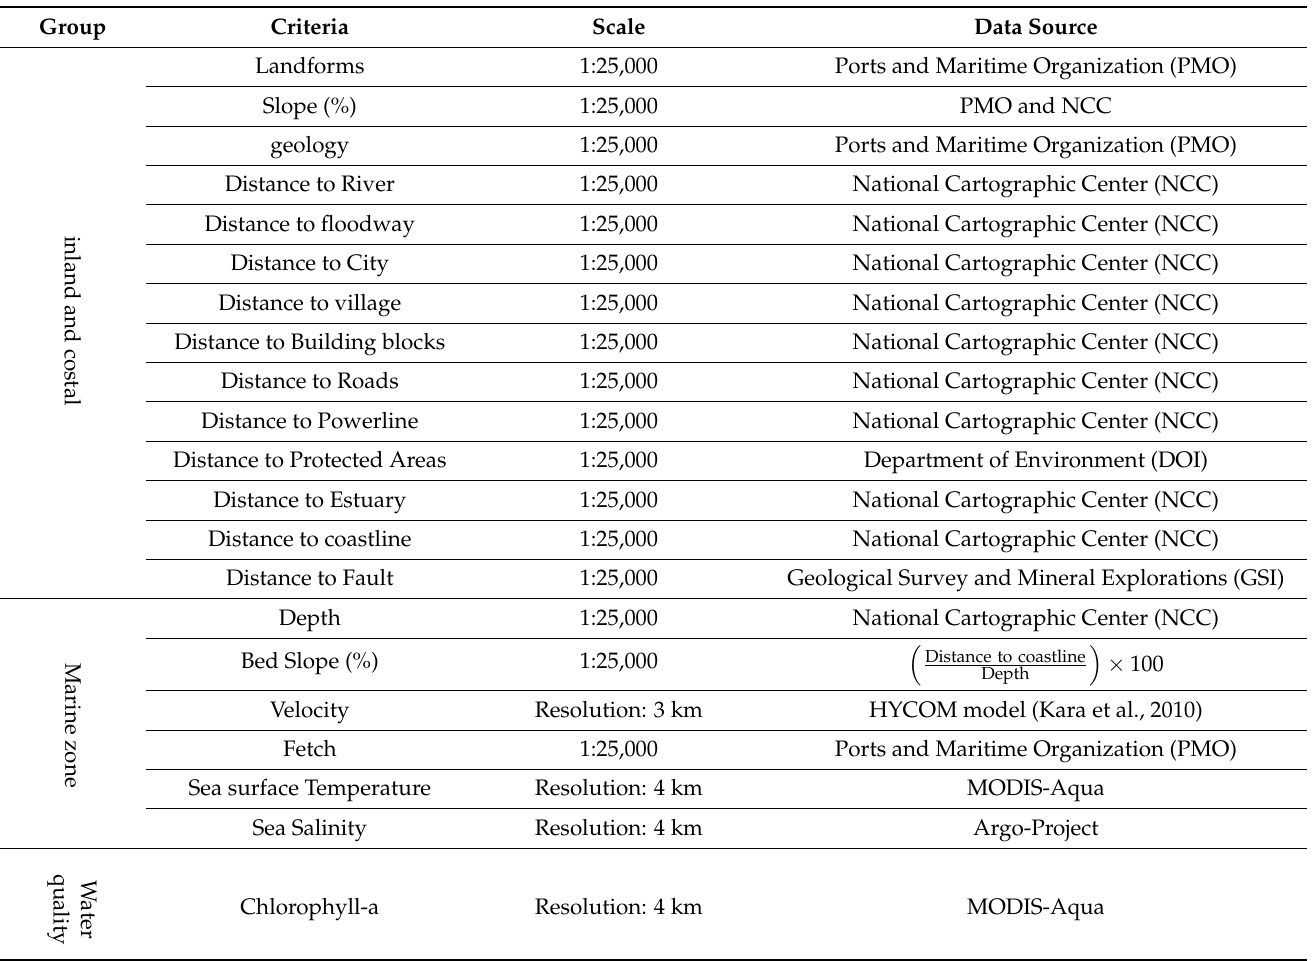
Table 1. Preparation of the database and data scale in three sections of environmental criteria, water criteria, and water quality